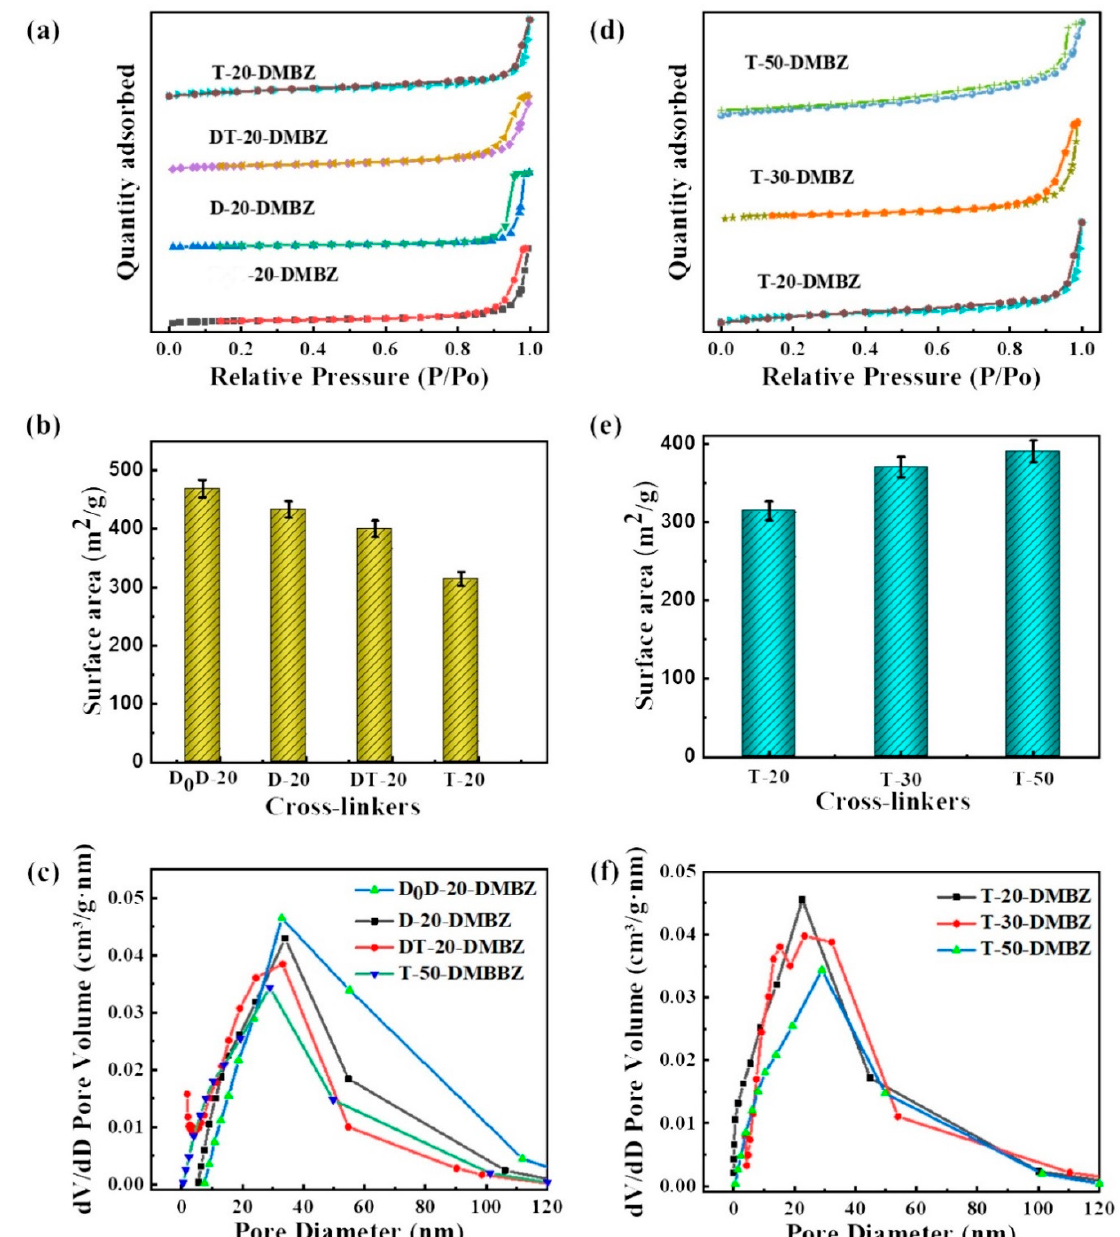
Figure 3. ( a ) N 2 adsorption-desorption isotherms of polyimide aerogels cross-linked with